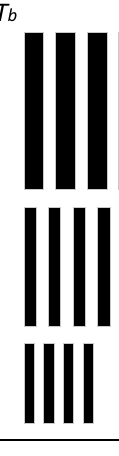
Figure 1. Image of the four-bar pattern for calculating MRTD.